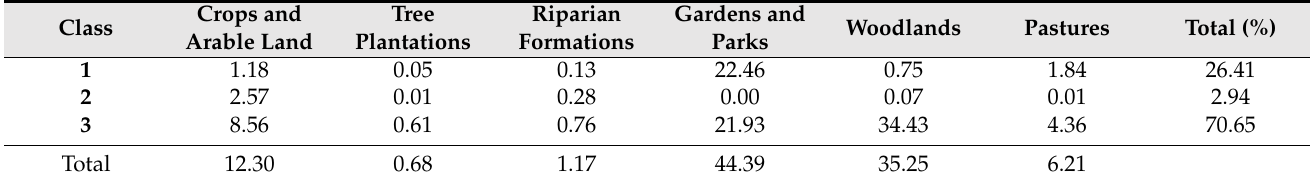
Table 9. Statistics concerning comparison between patches showing stable SPROD anomaly with vegetation type. Reported percentages refer to the total area of the 3 classes of anomaly stability for SPROD (about 4220 ha).